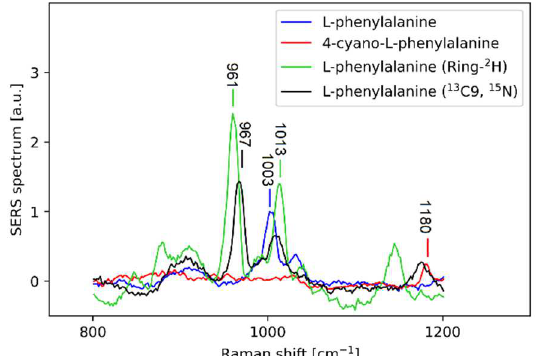
Fig. 2. SERS spectra of phenylalanine derivatives in the spectral region 800-1300 cm -1 . The spectra are normalized on the 1003 cm -1 phenylalanine peak and most prominent peaks denoted.